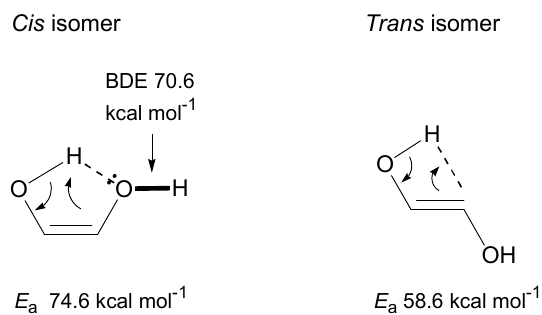
Figure 11. Influences of the stereochemistry of cis/trans enol on activation energy ( E a , kcal mol − 1 ) of keto–enol tautomerization by assuming the unimolecular mechanisms, as calculated at the MP4(SDQ)//DFT(M06-2X) level. BDE: bond dissociation energy.